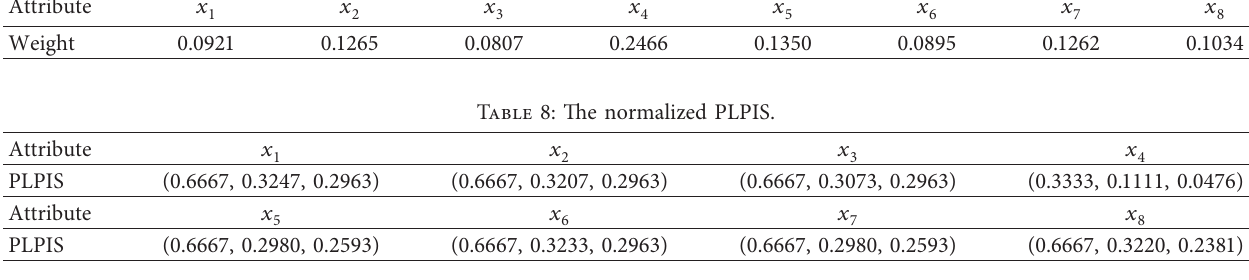
Table 9: The normalized PLNIS.